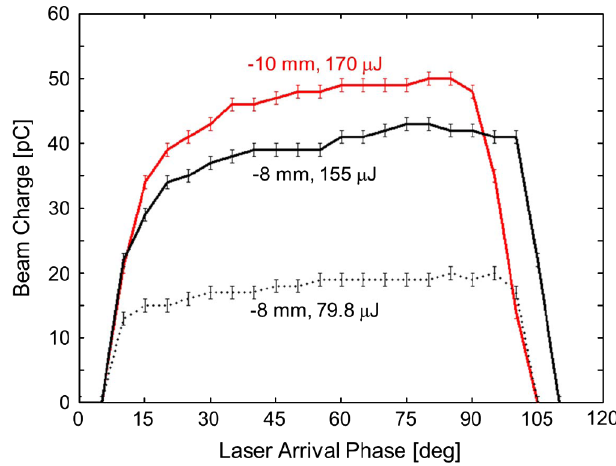
FIG. 16. Beam charge measured at the second diagnostics station as a function of laser arrival phase for the cathode at 10 mm retraction (red) and 8 mm retraction (black). The data taken at 10 mm retraction was with a laser energy of 170 (cid:1) J , while the data taken at 8 mm retraction used laser energies of 155 (cid:1) J (solid) and 79 : 8 (cid:1) J